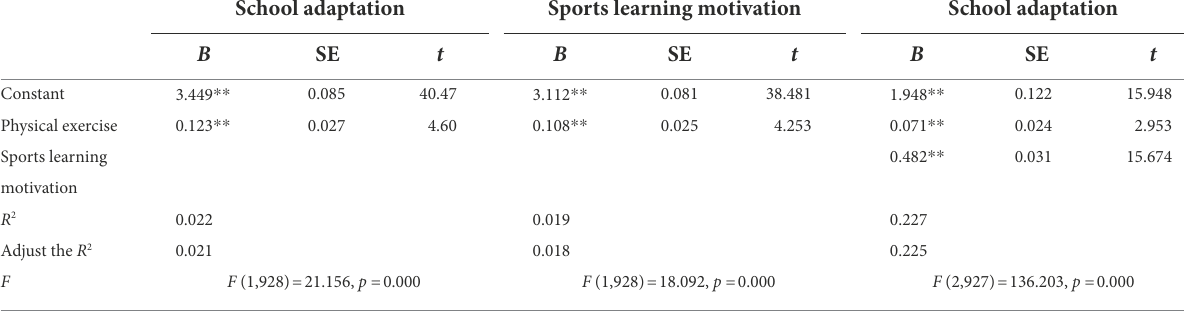
TABLE 5 Analysis results of the mediating effect of sports learning motivation.